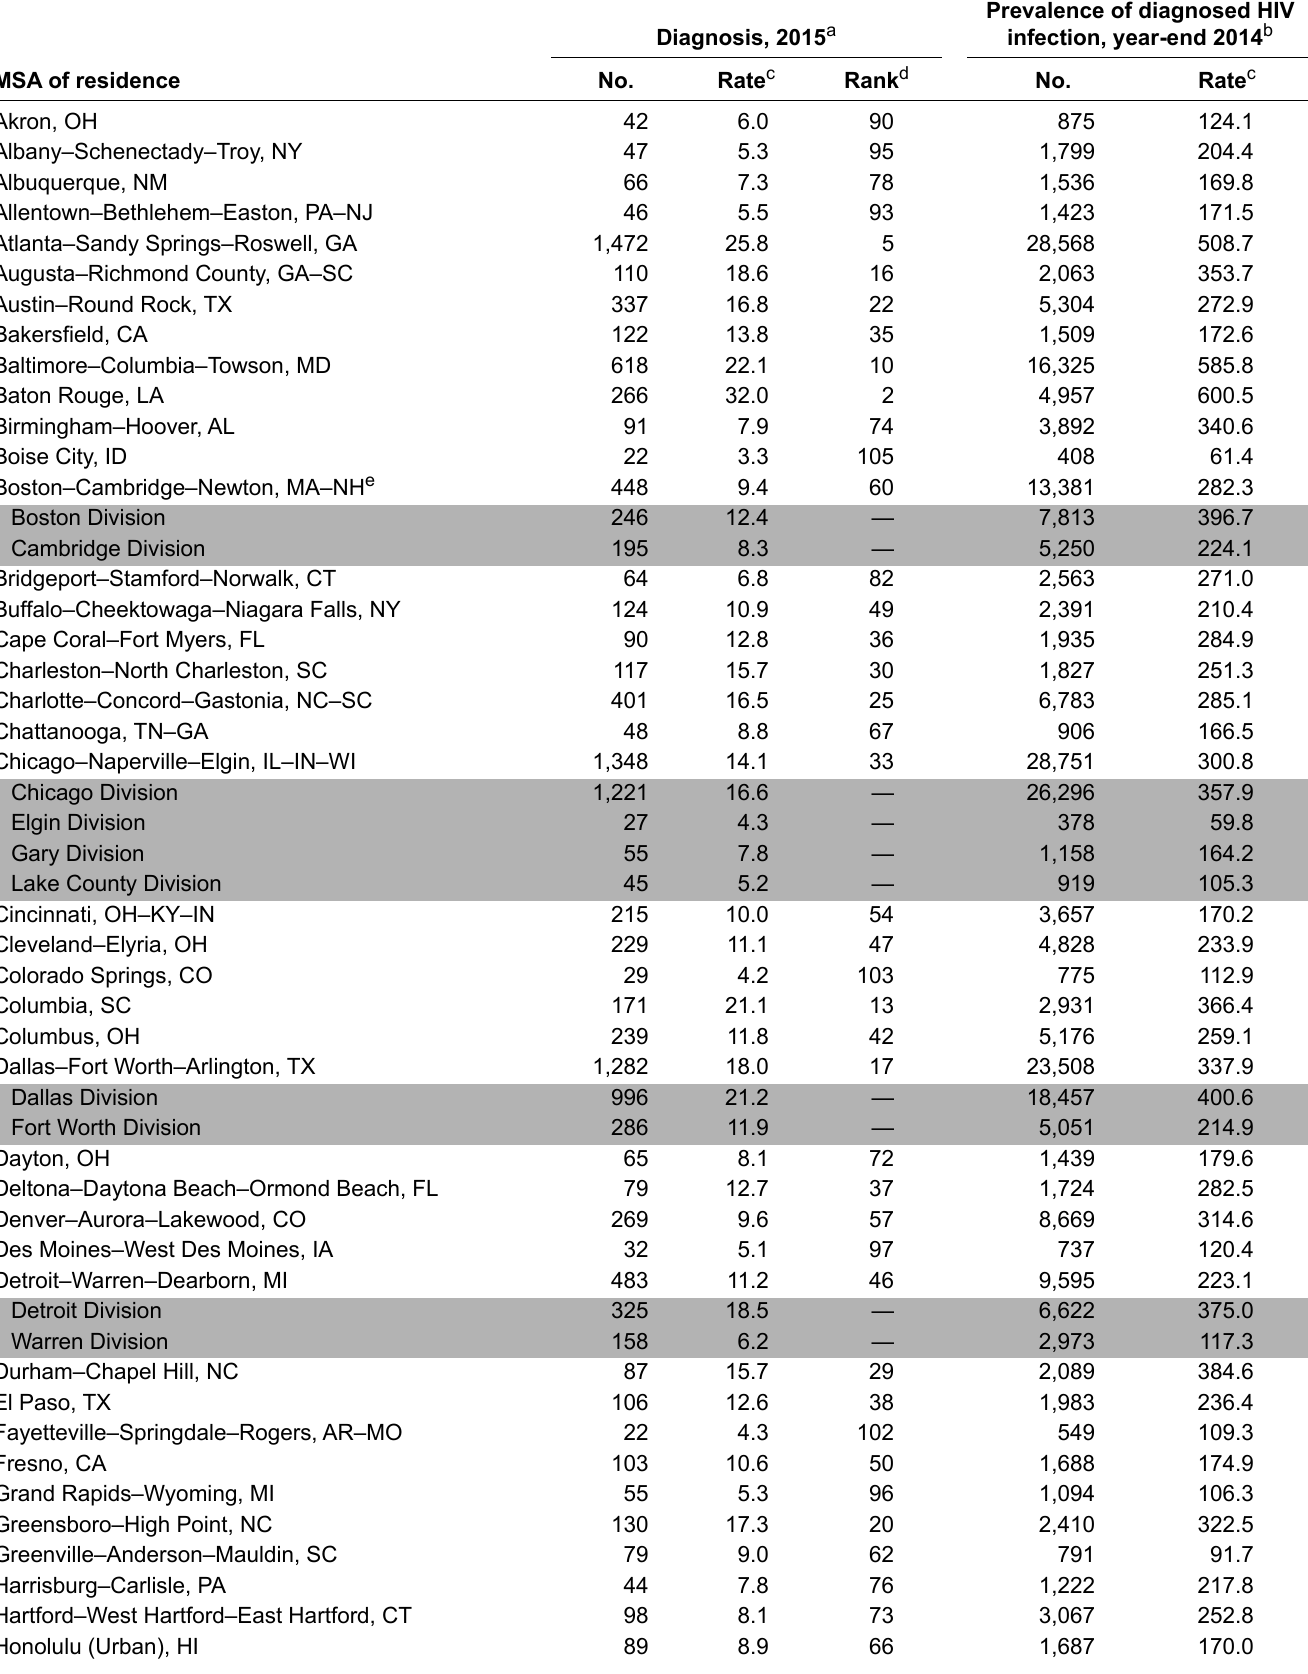
Table 26. Diagnoses of HIV infection, 2015, and persons living with diagnosed HIV infection (prevalence), year- end 2014, by metropolitan statistical area of residence—United States and Puerto